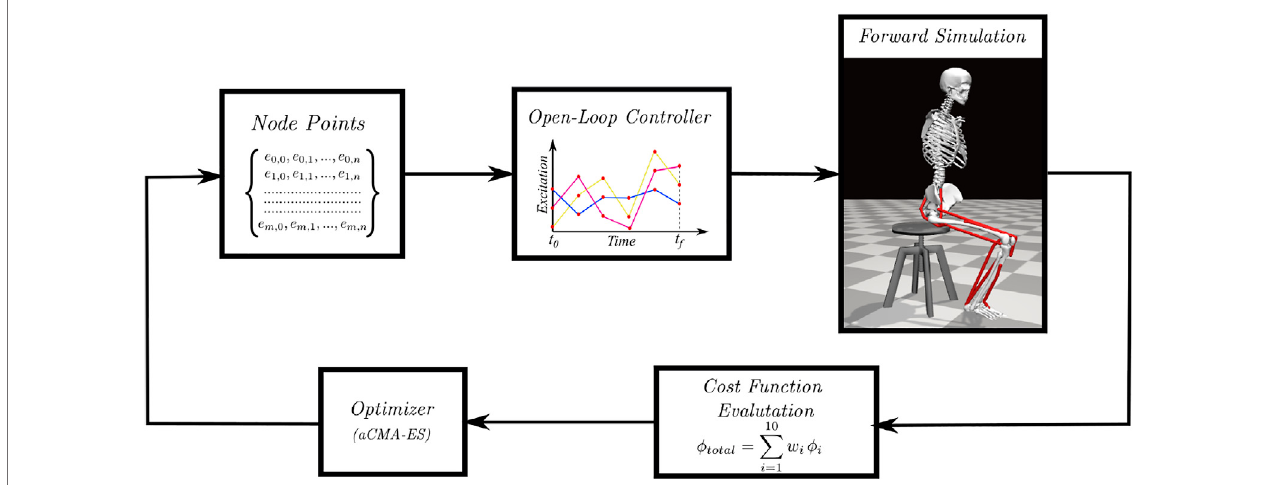
FIGURE 1 | Overview of single shooting optimization framework. The red dots in the open-loop controller represents the node points obtained from the discretization of excitation trajectories.